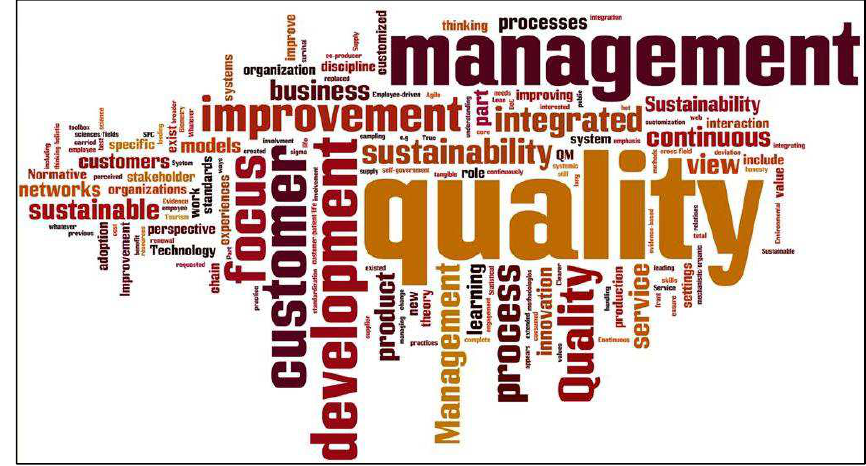
Figure 2 – Word cloud for QM in 20 years for all three